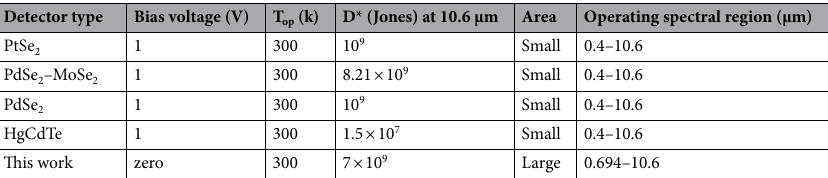
Table 5. A comparison of present work (antimony detector parameters) with commercial IR detectors 31,32 .